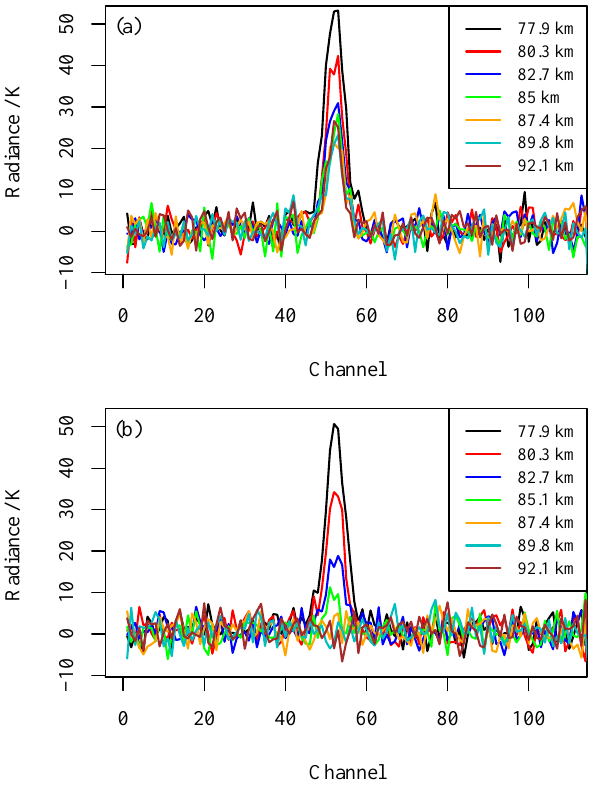
Fig. 3. The various stages used in the detection of unusual events in MLS H 2 O in the upper mesosphere. Data are for the same two orbits as in Fig. 1. Panel (a) shows the radiance (as Rayleigh-Jeans brightness temperature T B in K) averaged over the line centre chan- nels, as in the panel (ii) of Fig. 1. Panel (b) shows the same data with a daily zonal mean subtracted. Panel (c) shows the data from (b) averaged over the four minor frames (grey) and then smoothed (black line). Black dots show the points which were finally detected as statistically unusual.